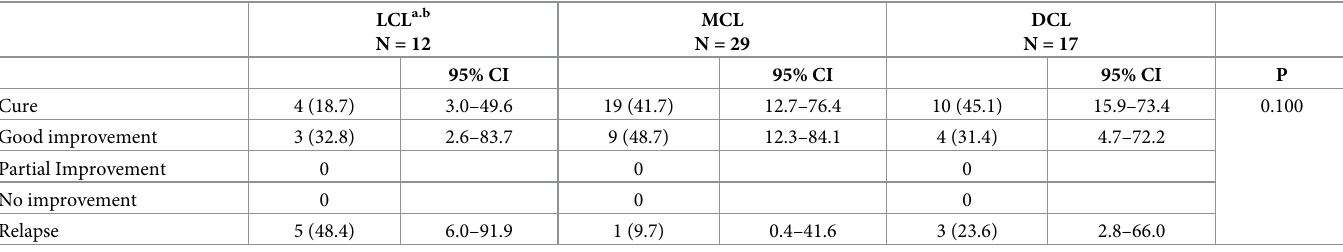
Table 5. Treatment outcome at day 90 by leishmaniasis